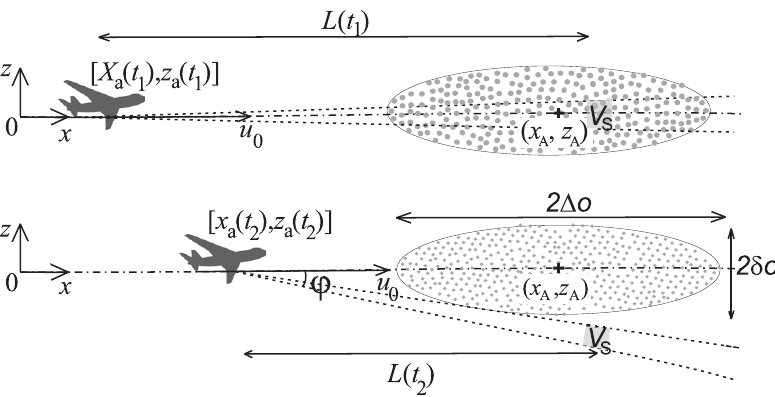
Figure 1. A schematic diagram of lidar measurements of the flight direction from an aircraft. The x a (t) , z a (t) coordinates represent the observer’s coordinates at sequential time points t 1 and t 2 ; the center of the observed clusters is marked with + , and their coordinates are x A , z A